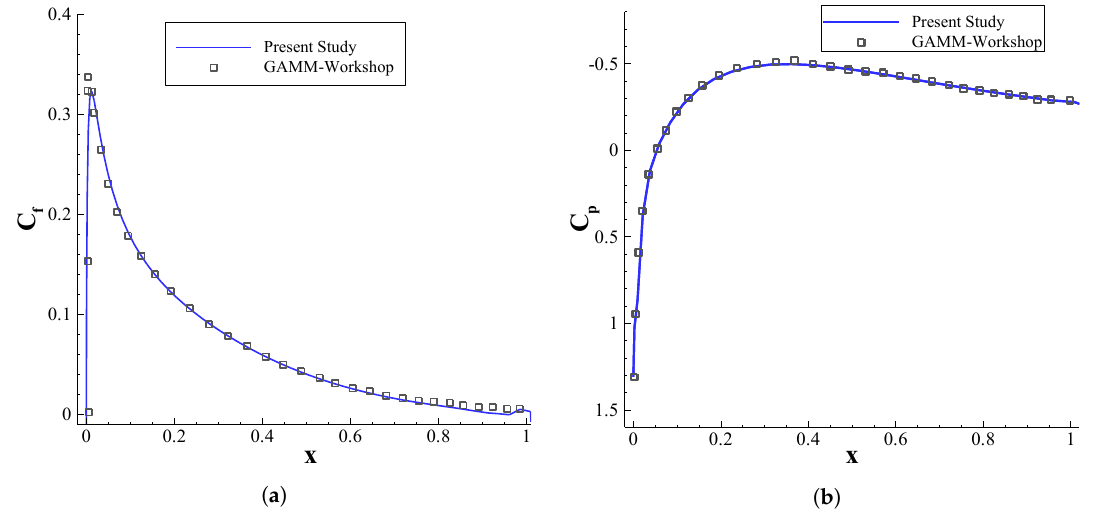
Figure 2. Profiles of ( a ) skin friction coefficient and ( b ) pressure coefficient over the NACA 0012 airfoil with M = 0.85 and Re = 500. The results of the current numerical simulation are also compared with the reference solution of the GAMM-Workshop [42].